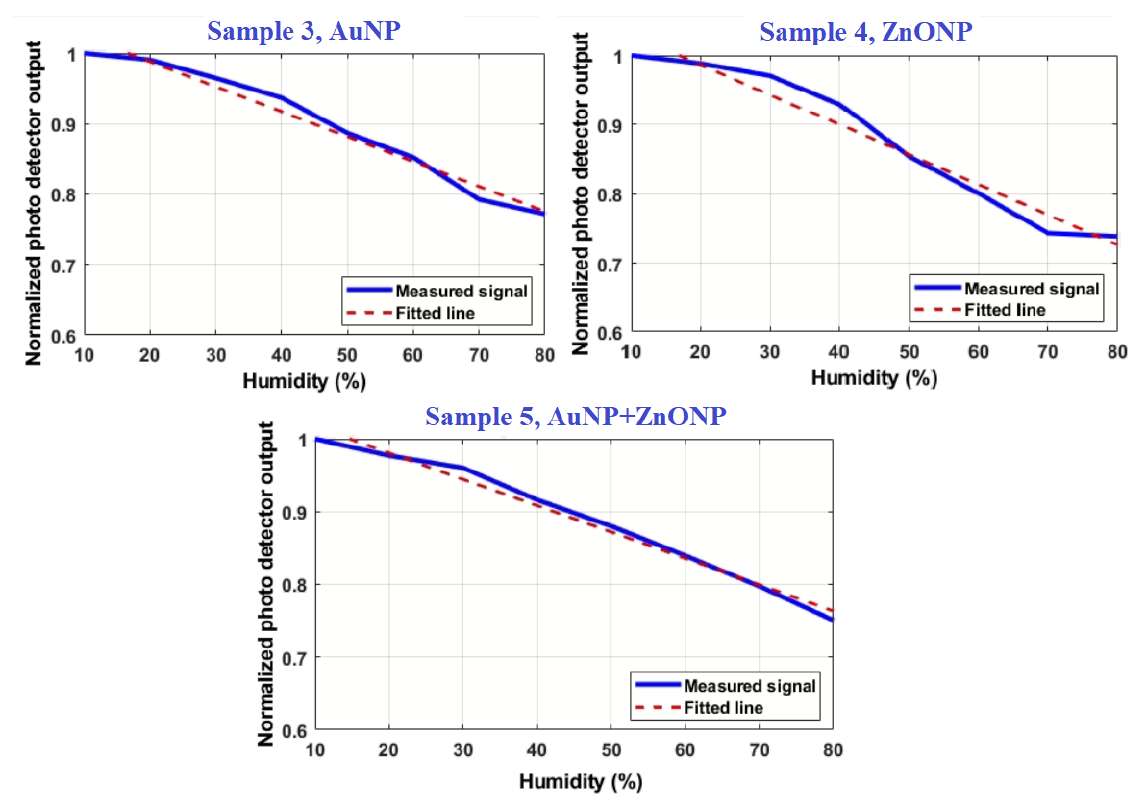
Figure 9. Response of the nanoparticle ‐ coated samples 3 to 5 to the change in humidity. (NP: nanoparticles).